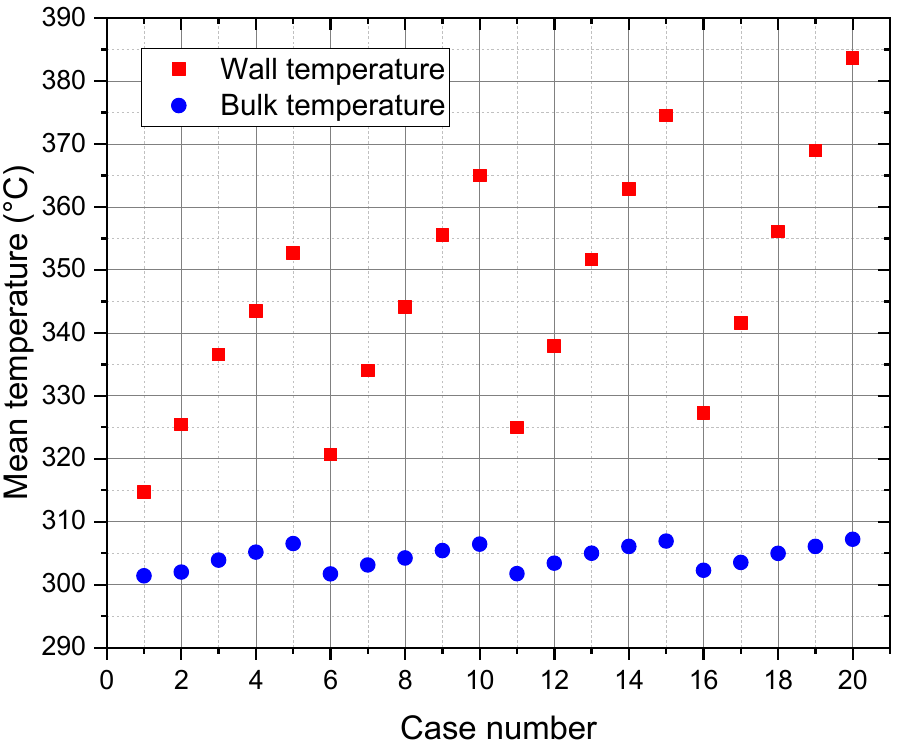
Figure 8. Measured temperature values at the mass flow meter.